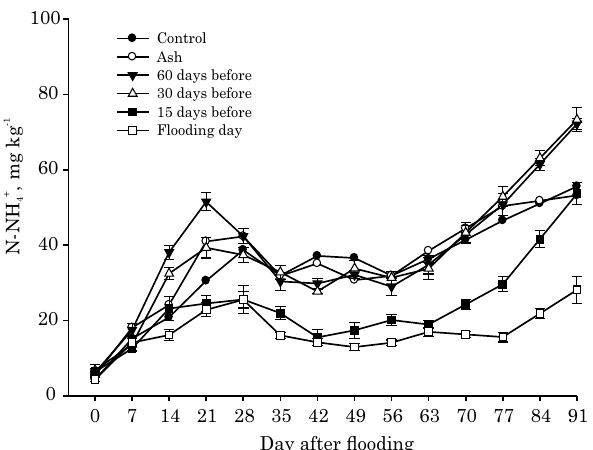
Figure 1. Temporal variation of N-NH 4+ in the soil after flooding as a function of the time of incorporation of rice straw preceding the soil flooding or incorporation of the ash from burned straw. Control: without straw or ash; Ash: ash incorporated on the day of flooding; 60